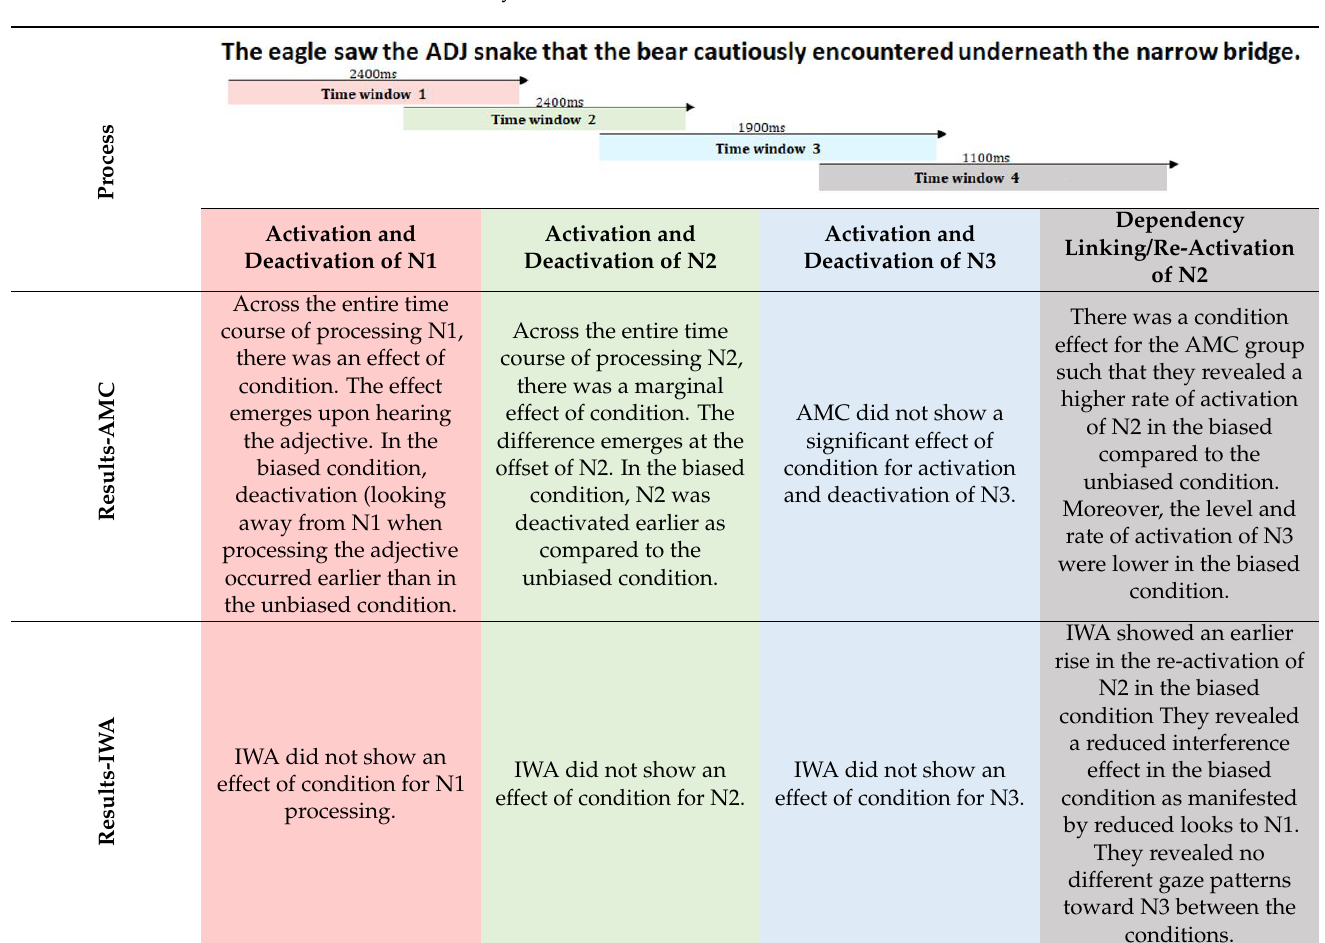
Table A4. Summary of the results for the online sentence processing of AMC and IWA based on GCA